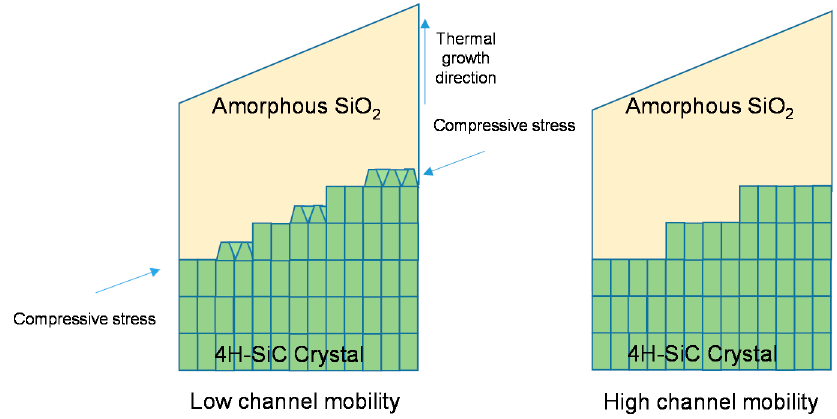
Figure 8. Schematic of a stressed ( a ) and a relaxed ( b ) SiO 2 / 4H-SiC interface. The thermal growth produces a compressive stress at the SiO 2 / 4H-SiC interface that limit the MOSFET channel mobility. When the interfacial stress is released (e., the MOSFET channel mobility increases.